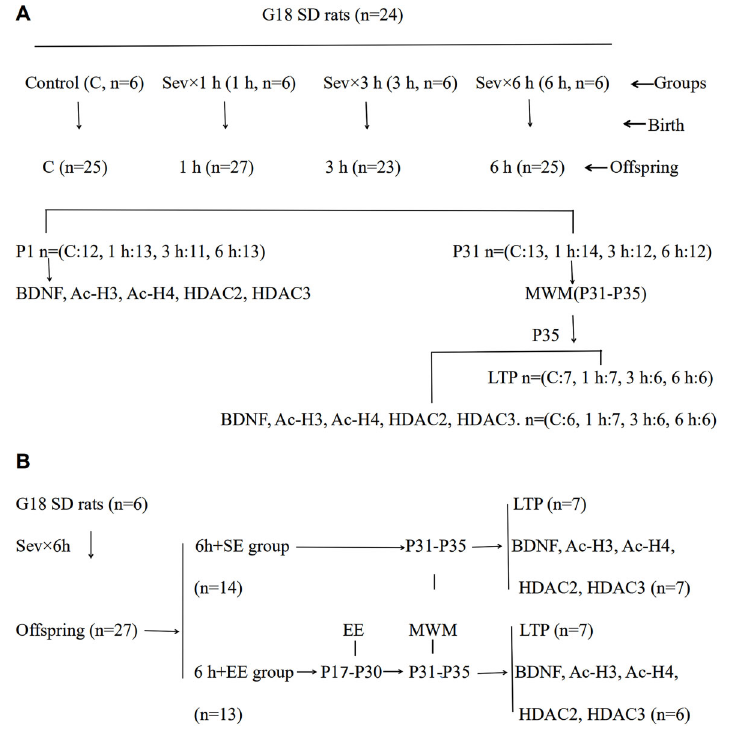
Figure 1. Flowchart of the ( A ) fi rst and ( B ) second experimental protocols. G18: gestational day 18; P1 – P35: postnatal days 1 to 35; MWM: Morris water maze; Sev: 2.5% sevo fl urane; EE: enriched environment; SE: standard environment.